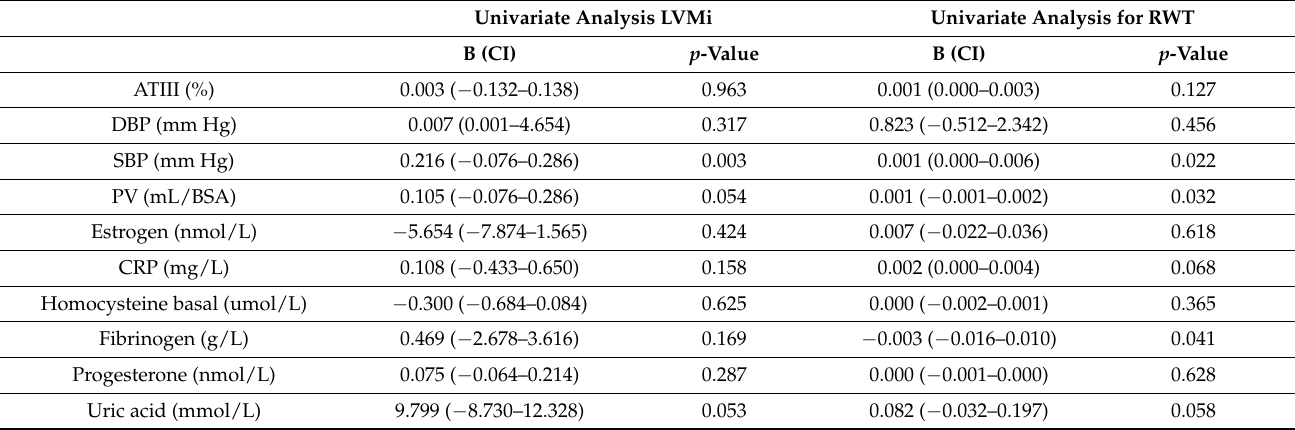
Table 2. Univariable linear regression analysis with LVMi and RWT as outcome using transformed data set. Univariate Analysis LVMi